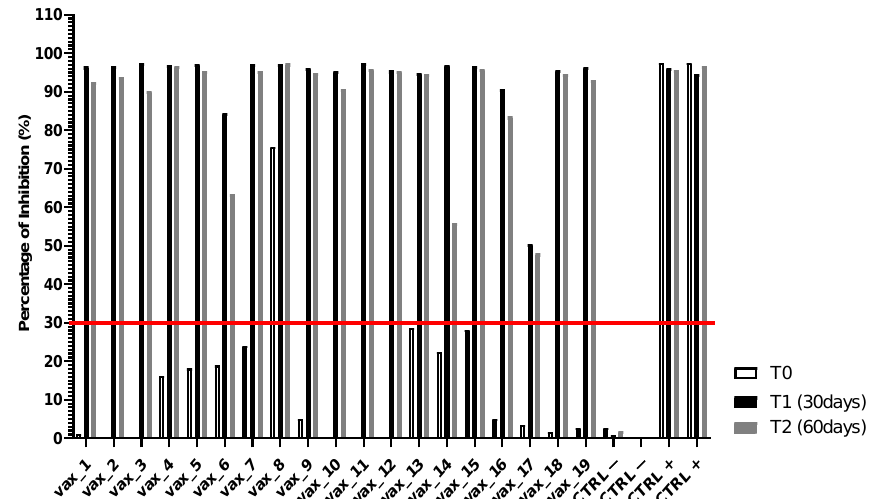
Figure 3. Qualitative direct detection of total neutralizing antibodies to SARS-CoV-2 at day 0 (T0), day 30 (T1), and day 60 (T2) after administration of the first dose of Pfizer/BioNTech.